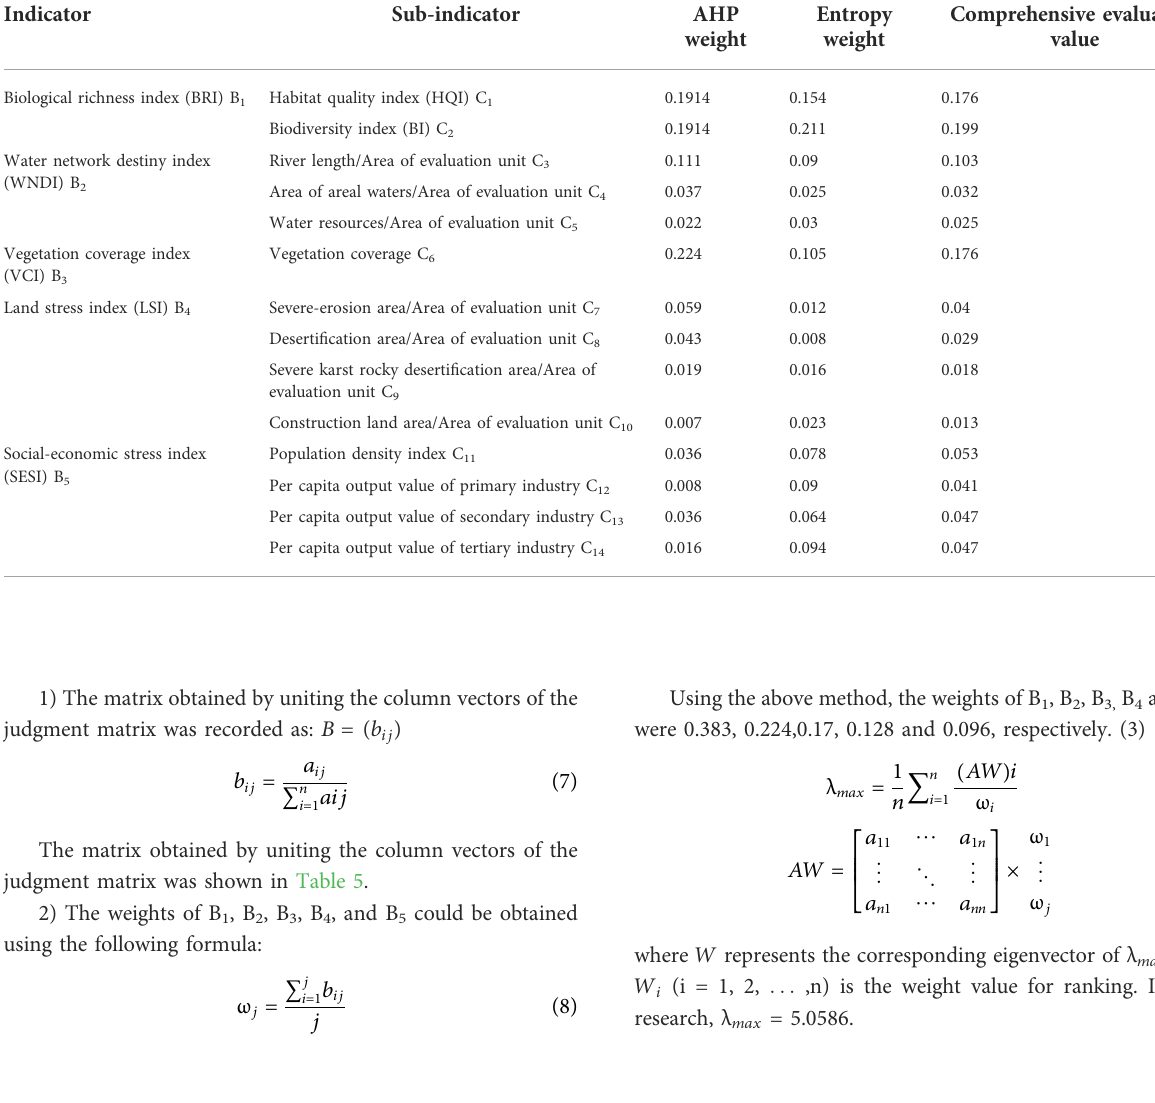
Comprehensive evaluation weight